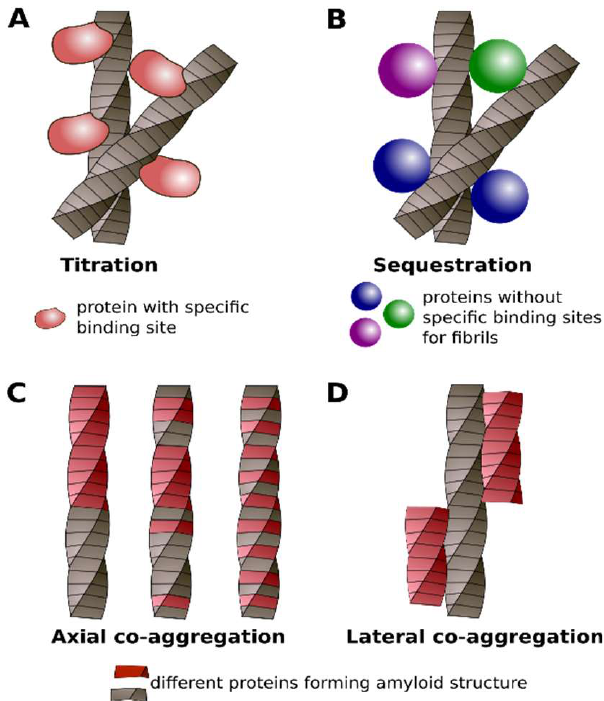
Figure 4. Different classes of protein co-aggregation with or via amyloids: titration ( A ), sequestration ( B ), axial ( C ) and lateral ( D ) co-aggregation. See details in the text.